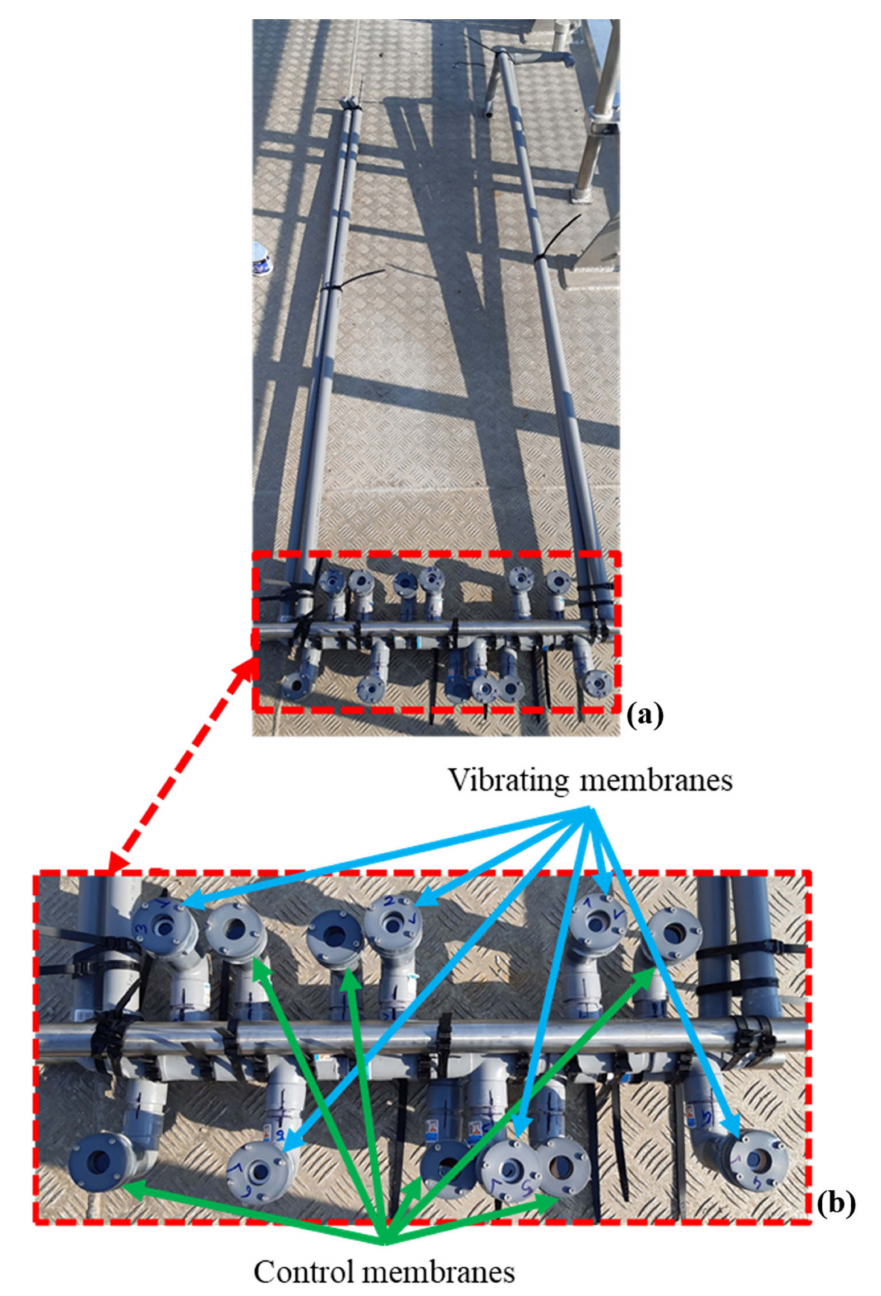
Figure 8. ( a ) In Situ device; ( b ) zoom on the immersed part of the